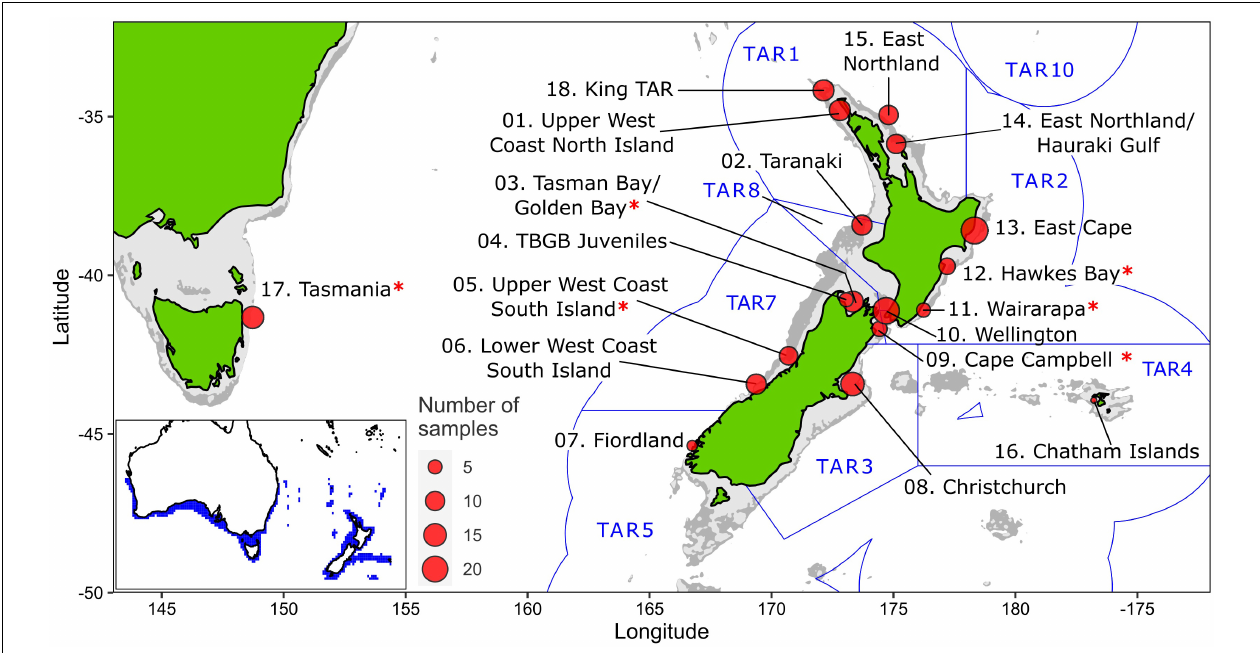
FIGURE 2 | Sampling sites of tarakihi (sites 1–17) and king tarakihi (site 18) used in this study. King TAR: king tarakihi from Three Kings Islands. Red asterisks ( ∗ ) indicate populations that are adaptively divergent based on outlier analysis. Blue lines and labels correspond to the New Zealand Exclusive Economic Zone and the quota management areas for tarakihi (TAR 1–5, 7–8, 10). The bathymetric contour is shown in light gray (125 m) and dark gray (1000 m). Bottom left: range of tarakihi in blue area (Kaschner et al.,